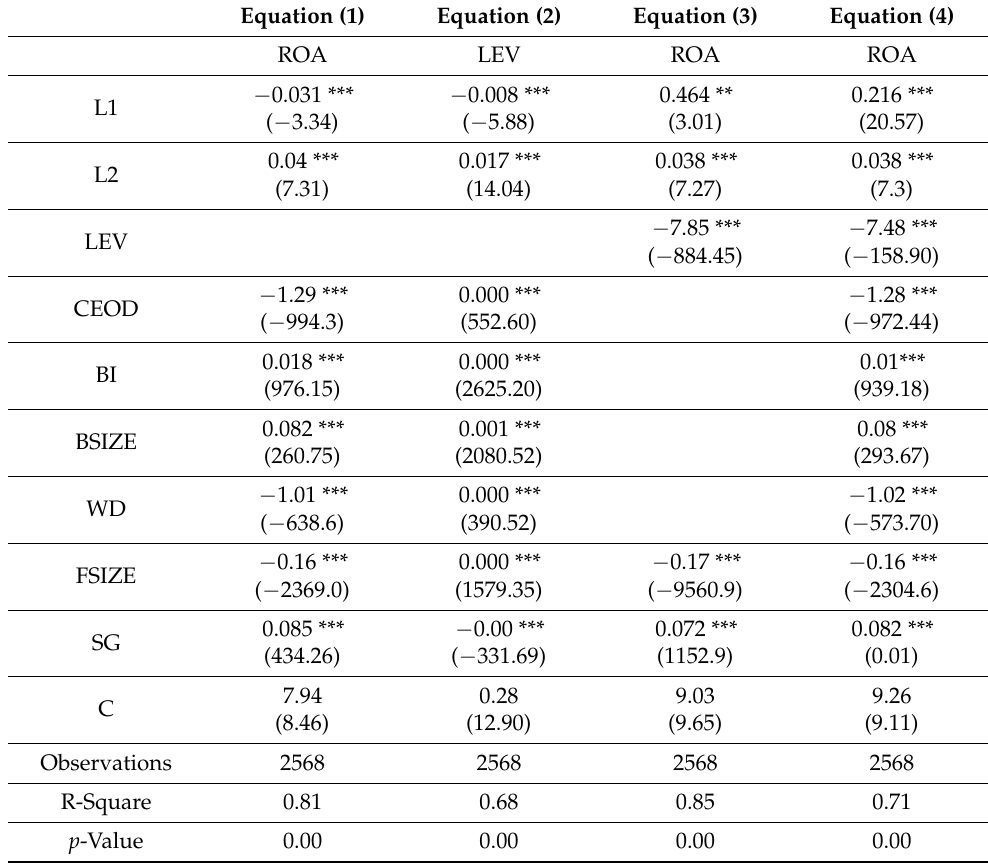
Table 7. Two-step system dynamic panel estimation across all